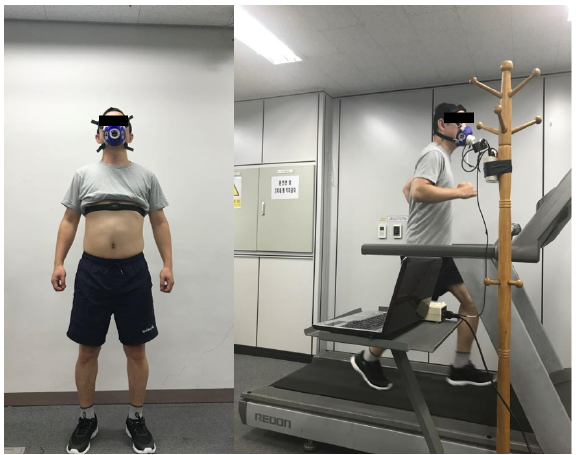
Figure 3. Example figures of the experimental equipment and process. During the experiment, participants wore a chest strap and a calorimeter to measure HR and EE, respectively. Each participant ran on a treadmill at a speed varying from 3 to 10 kph, which increased by 1 kph per every 2 min (total 16 min ran) and they were instructed to run at a constant speed as much as